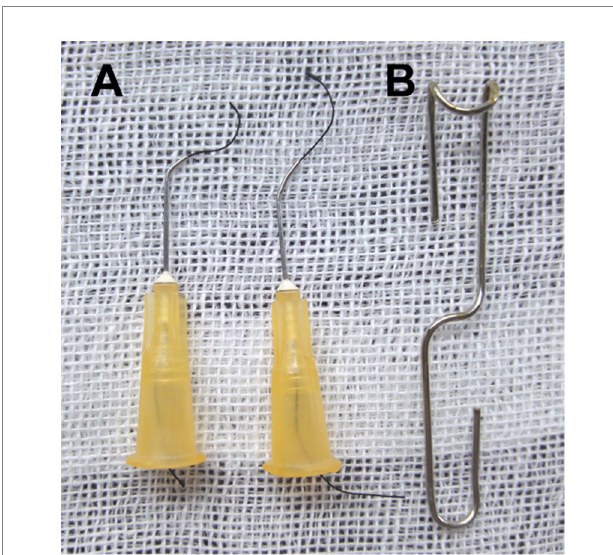
FIGURE 1 Homemade surgical instruments. (A) Creating the ligation spacer and curved needle with suture: bend the blunt 25-gauge needle 30 ° ~45 ° with a needle holder. (B) Making a simple surgical retractor with the paper clip, as illustrated